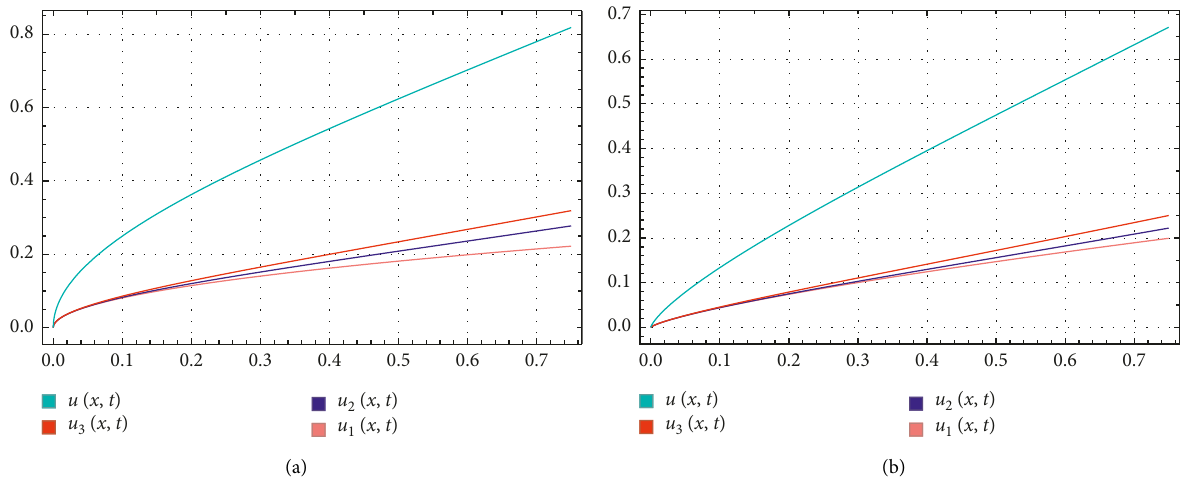
Figure 9: The graphical comparison of solutions for (30) through various values of t at x � 0 . 75 , α � 0 . 5 , 1, respectively. (a) The graphical comparison of solutions for (30) through various values of t at x � 0 . 75; α � 0 . 5. (b) The graphical comparison of solutions for (30) through various values of t at x � 0 . 75; α �